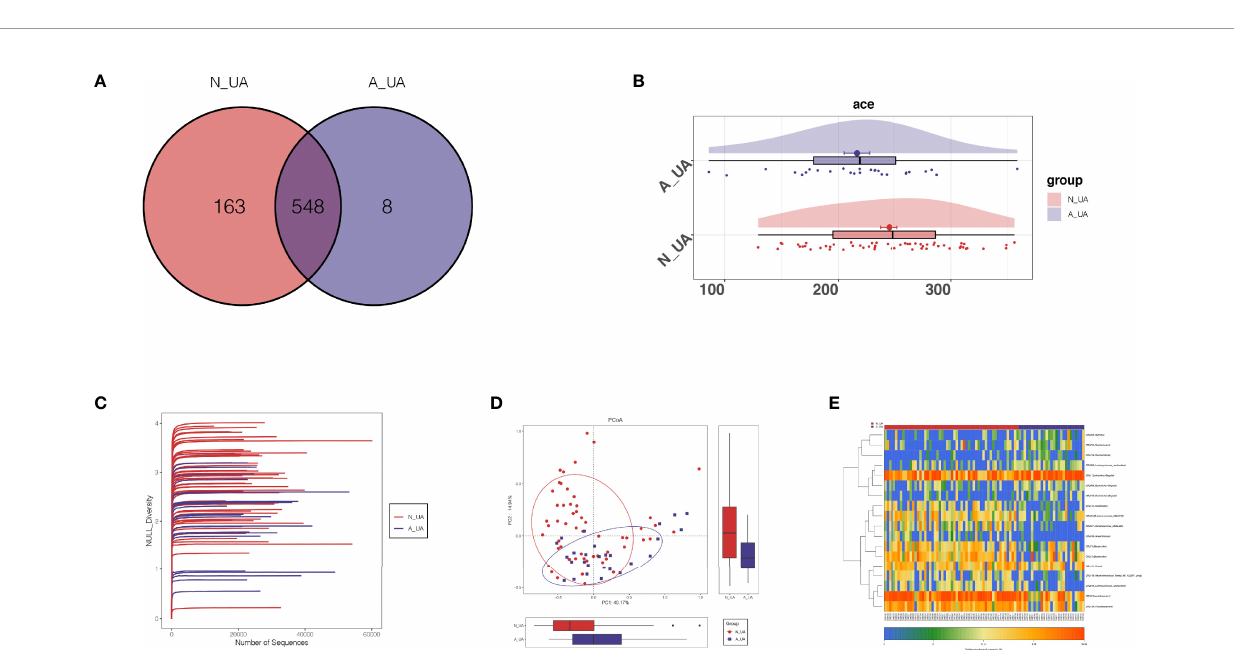
fi rst and second grouping: 0.014 vs. 6.97 × 10 − 5 ), Faecalibacterium (p-values for fi rst and second grouping: 0.050 vs. 0.003), and [Eubacterium]_coprostanoligenes _group (p- values for the fi rst and second grouping: 0.003 vs. 4.73 × 10 − 4 )